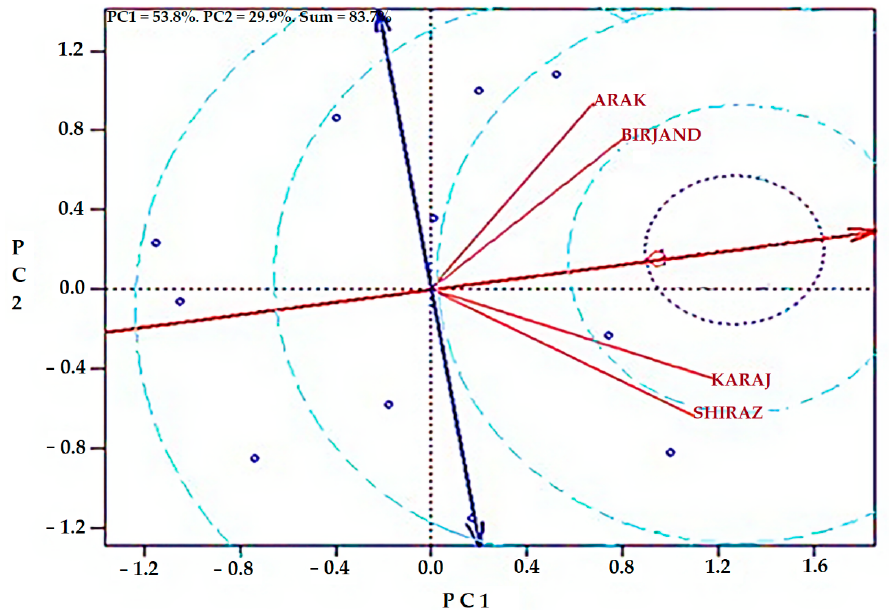
Figure 4. GGE-biplot for comparing the environments with the ideal environment. (G1: KSC703, G2: KSC260, G3: KSC705, G4: KSC400, G5: KSC706, G6: KSC704, G7: KSC707, G8:DC370, G9: SC647, G10: SC302, G11: SC604, G12: SC301). (The arrow is the best point that the software determines to identify the best genotype and environments).